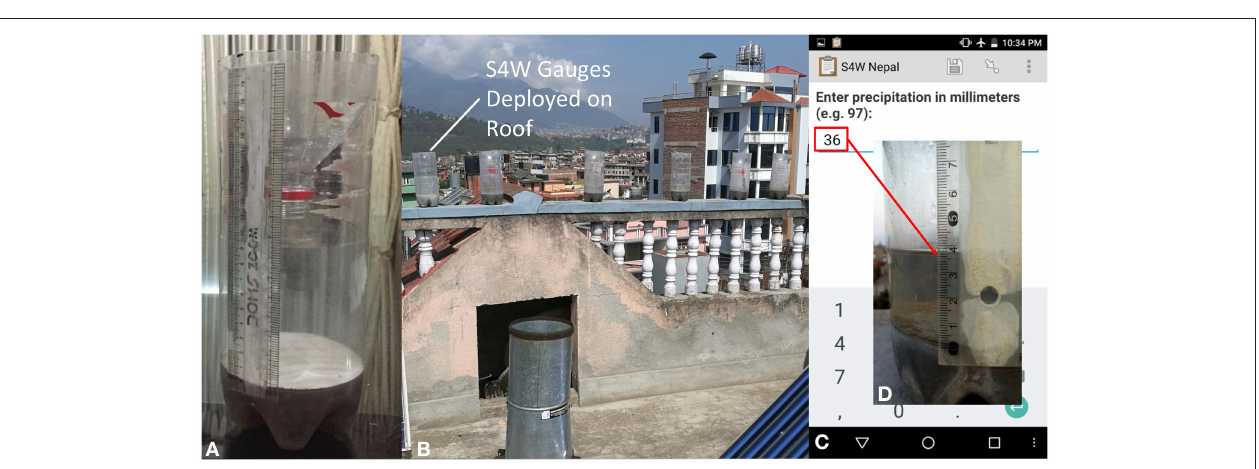
FIGURE 2 | (A) Repurposed plastic bottle after placement of concrete, ruler, and inverted lid. (B) S4W Gauges installed on the roof of the S4W-Nepal office in Thasikhel, Lalitpur, Nepal. After selecting the parameter to measure, the citizen scientist (C) entered their observation of precipitation (mm) and (D) took a picture of the water level in the S4W rain gauge before emptying it. Each record was reviewed by S4W-Nepal staff to ensure that the numeric entry from the citizen scientist (C) matched the photographic record of the observation (D) . Any observed discrepancies were corrected, and records of edits were